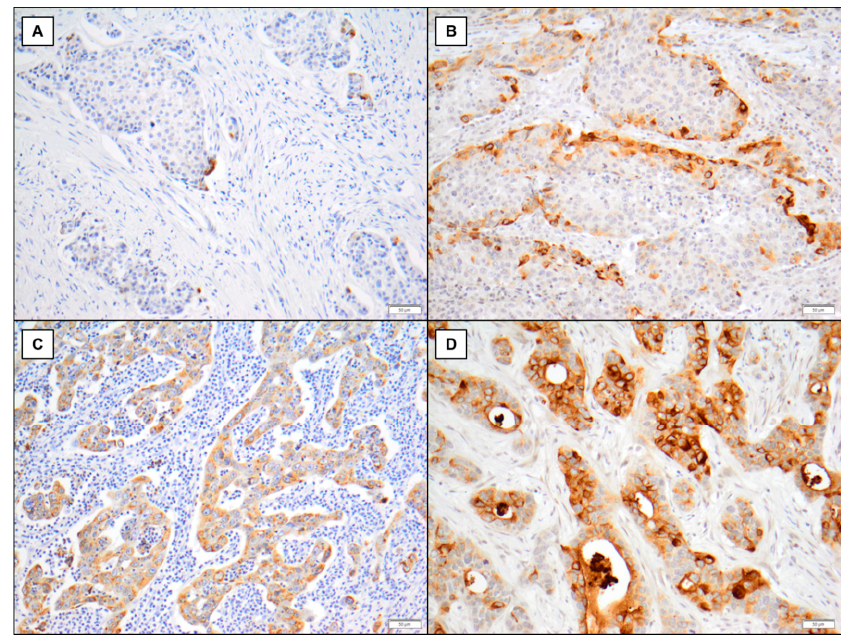
Figure 1. Different staining patterns in MMP-7 immunohistochemistry. ( A , B ) Tumor cells only show strong immunopositivity at the tumor–stroma interface. ( A ) Only scattered cells are positive. ( B ) MMP-7-protein is expressed in a nearly linear fashion in tumor cells at the tumor–stroma border. ( C , D ) Nearly all tumor cells exhibit a diffuse and moderate to strong MMP-7-expression with strong intratumoral neutrophil infiltration in ( C ) and only very few immune cells in the tumor stroma in ( D ). However, in both ( C , D ) the tumor cells in the trabecular and/or glandular infiltrations are all in close proximity to the tumor–stroma interface. All 200 ×